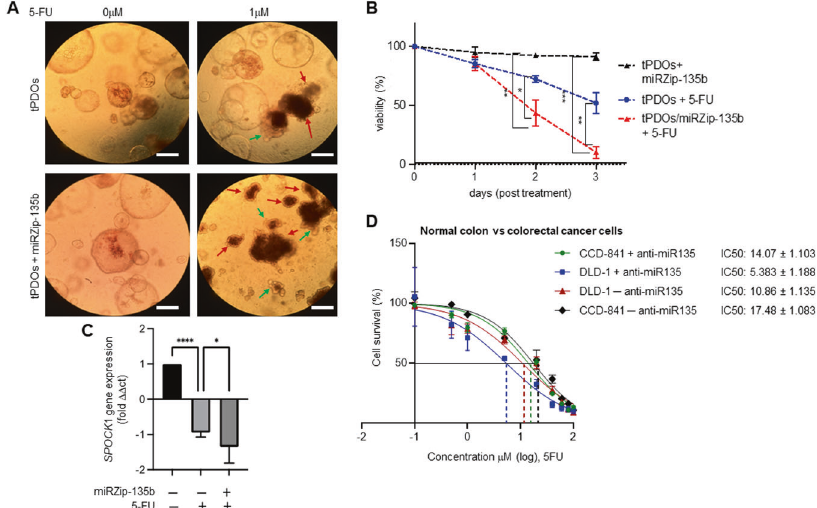
135b-knockdown in tPDOs induced cytostatic (red vs blue) in response to 5-FU (1 mM) determined and quanti fi ed by MTT reduction. Bars are ±SEM ( n = 3). * p < 0.05; ** p < 0.01; *** p < 0.001. C Anti-miR-135b/5-FU axis synergistically prevents SPOCK1 expression in 5-FU-treated CRC